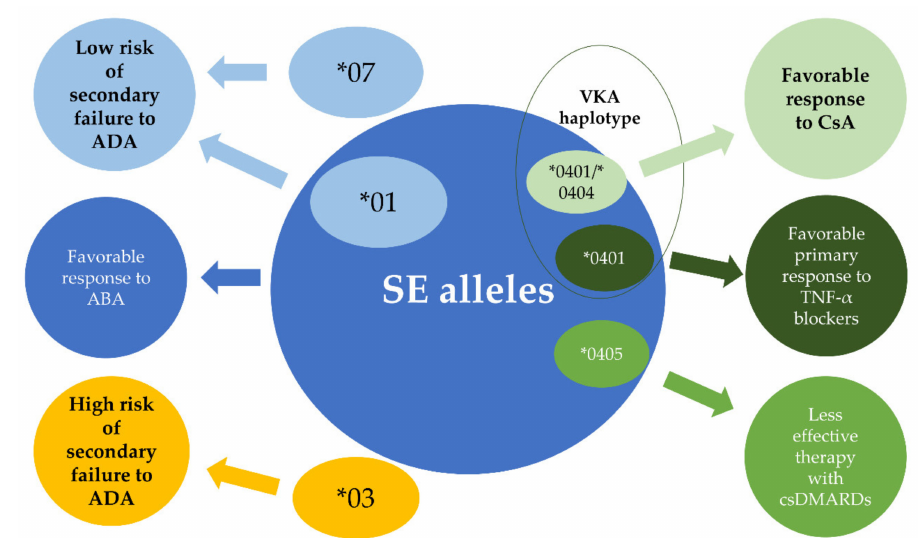
Figure 6. Potential HLA-DRB1 causal variants influencing specific treatment responses. Classical synthetic disease-modifying antirheumatic drugs (csDMARDs) include methotrexate, sulfasalazine, leflunomide, antimalarial drugs (chloroquine, hydroxychloroquine); CsA = cyclosporine; ADA = adalimumab; ABA =